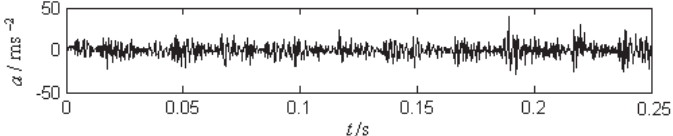
Fig. 9. The vibration acceleration signal of a roller bearing with inner-race fault.